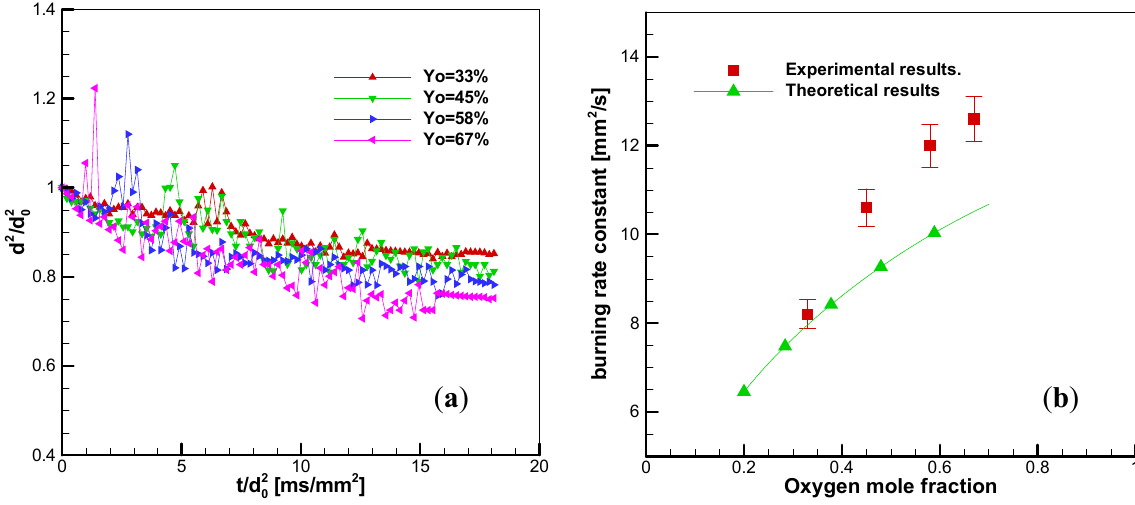
Figure 6. ( a ) Temporal variation of droplet size for different oxygen fraction at P = 0.6 MPa; ( b ) Variation of burning rate constant with oxygen